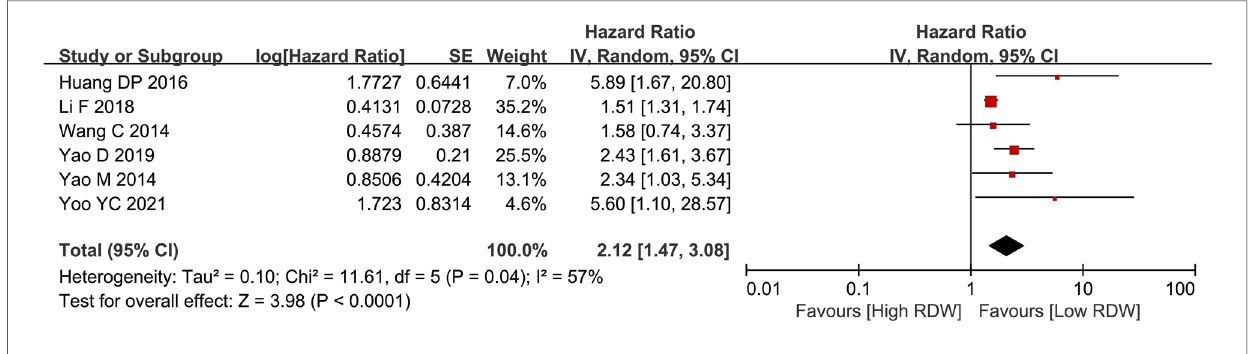
FIGURE 2 Os between the high RDW group and the low RDW group. Abbreviation: OS, overall survival; RDW, red blood cell distribution width.